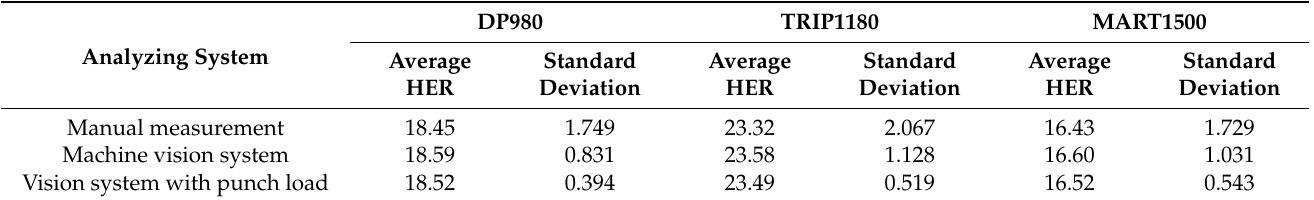
Table 5. Measured HER with various analyzing